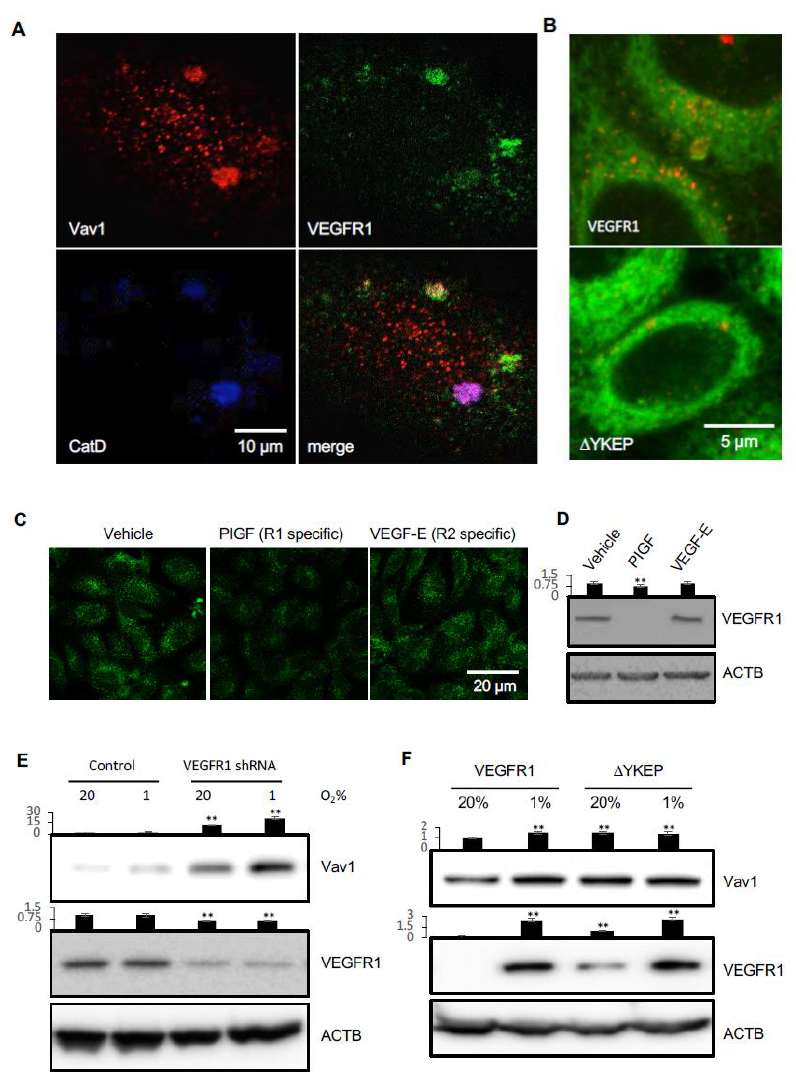
Figure 3. VEGFR1 carries Vav1 to lysosomes for degradation. ( A ) HUVECs were immunostained for Cathepsin D, Vav1 and VEGFR1, and analyzed by confocal microscopy. ( B ) HeLa cells were co-transfected with expression vectors for Vav1 and wild type VEGFR1 or the Vav1 binding domain deleted construct, ΔYKEP. Cells were stained with Lamp2 (red) and Vav1 (green). ( C ) HUVECs were stimulated with either PlGF or VEGF-E at 50 ng/mL for 5 h, followed by staining with antibodies for Vav1 (green) and imaged under confocal microscopy. ( D ) HUVECs were stimulated with either PlGF or VEGF-E at 50 ng/mL for 5 h, followed by Western blot to detect VEGFR1 levels. ( E ) HUVECs were infected with lentiviral vectors carrying scrambled or VEGFR1 shRNAs and cultured in either 20% O 2 or 1% O 2 incubators. Cell lysates were analyzed by Western blot for Vav1 and VEGFR1. ( F ) HUVECs were transfected with expression vectors for Vav1 with either VEGFR1 or ∆ YKEP VEGFR1. The levels of Vav1 and VEGFR1 were assessed by Western blot. Mean ± SD, ** p < 0.01. The whole western blot images please find in Figure